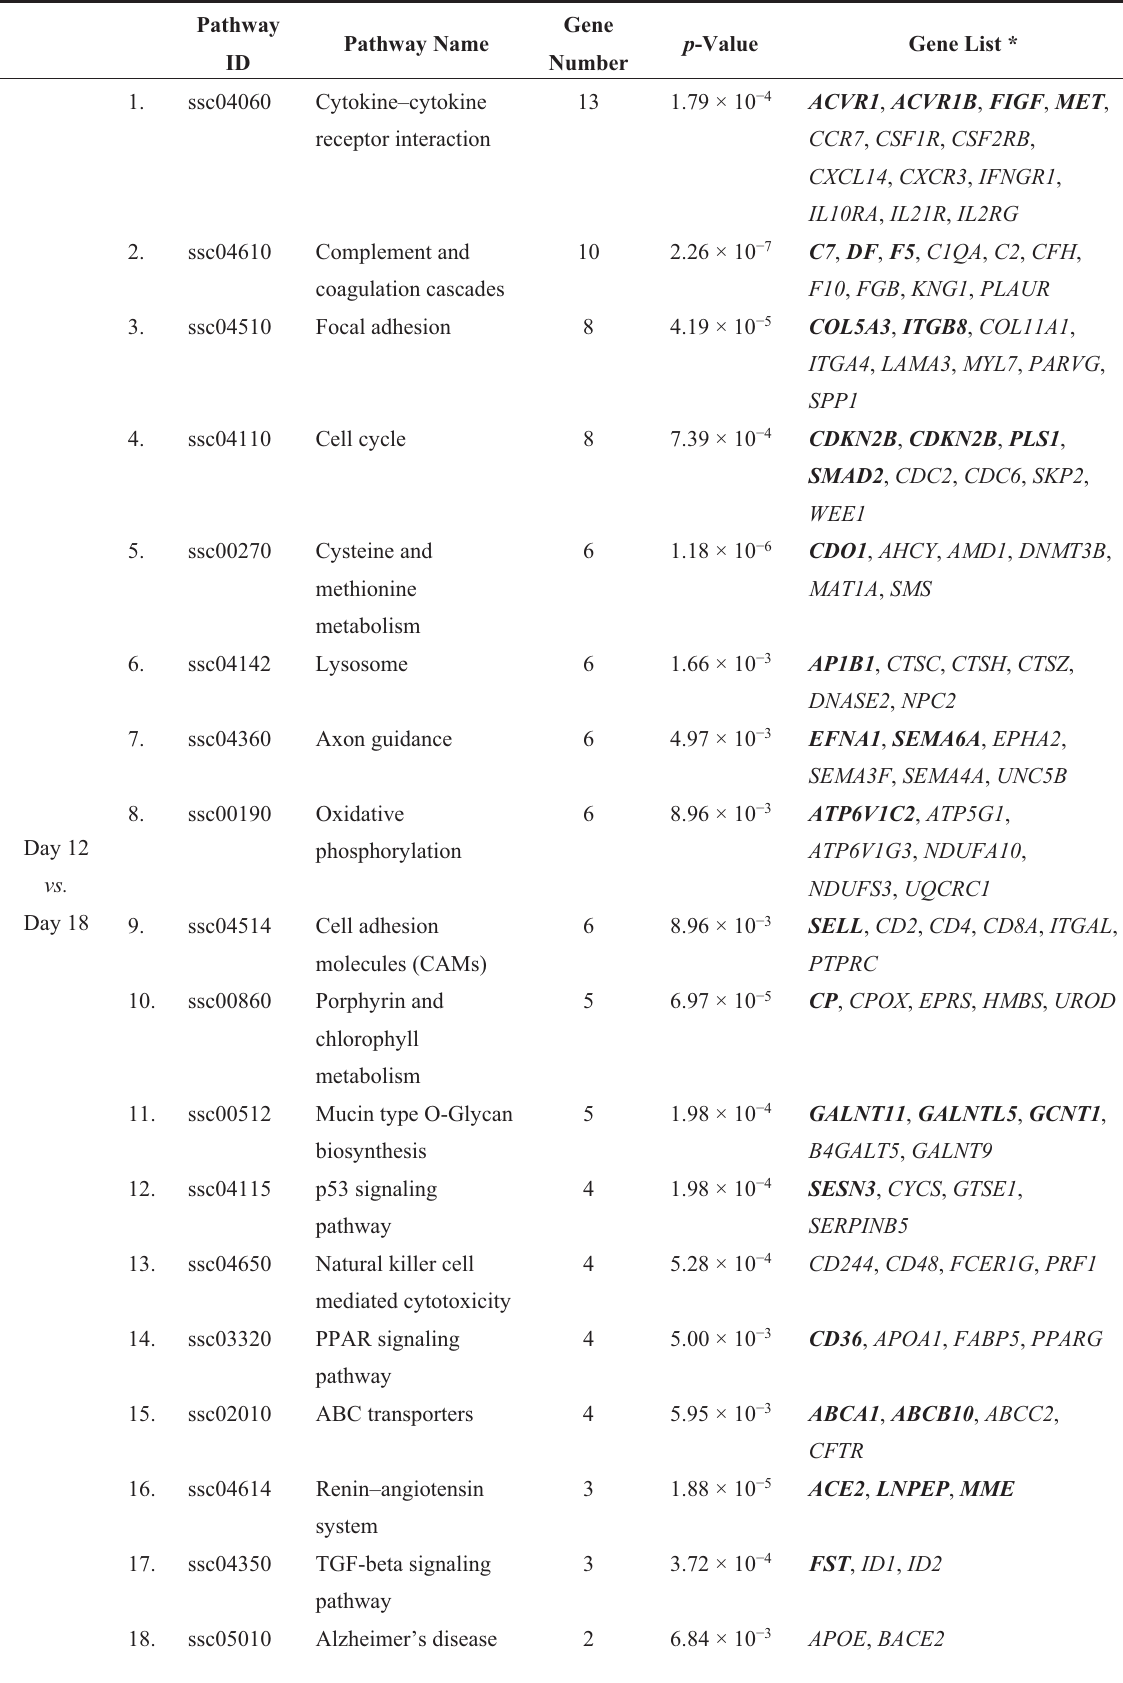
Table 4. The most significant DEGs biological pathways examined with the KEGG database ( p (cid:5)